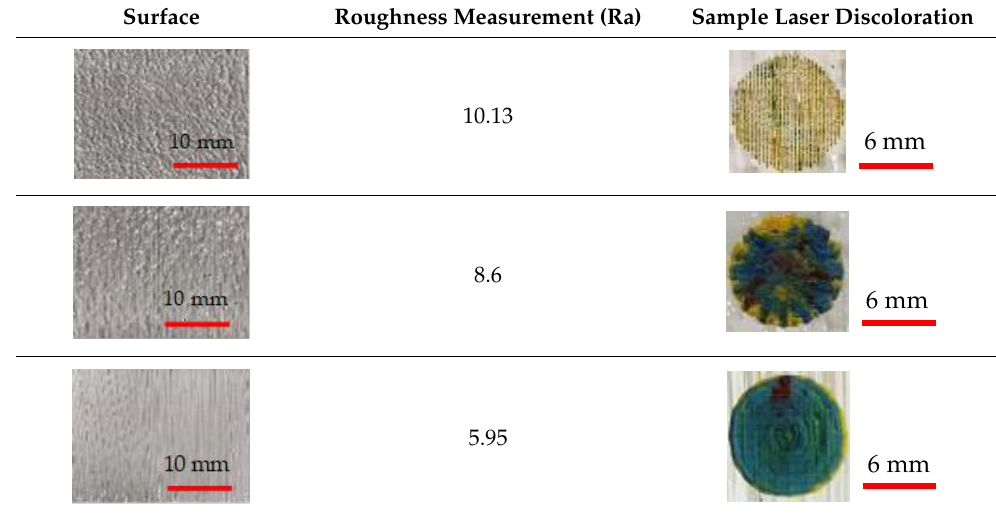
Table 1. Illustrations and roughness measurements of different surfaces.